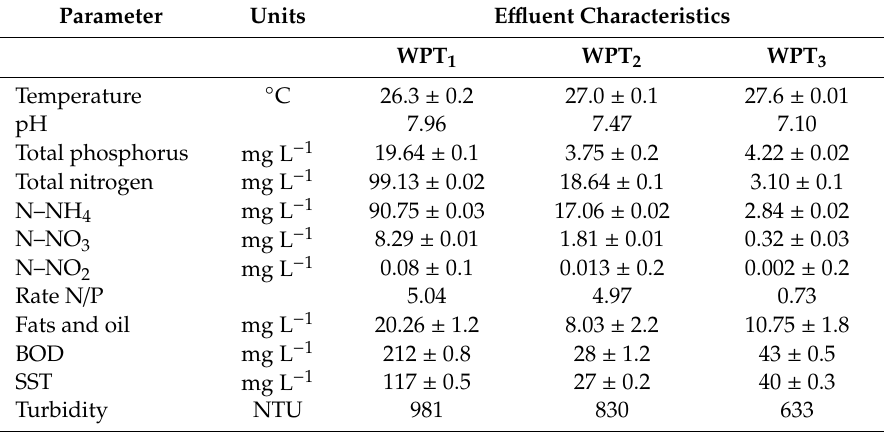
Table 1. Chemical parameters determined for wastewater e ffl uent of treatment plants (WPT). The results represent average values (samples in triplicate) and standard deviation ( ±